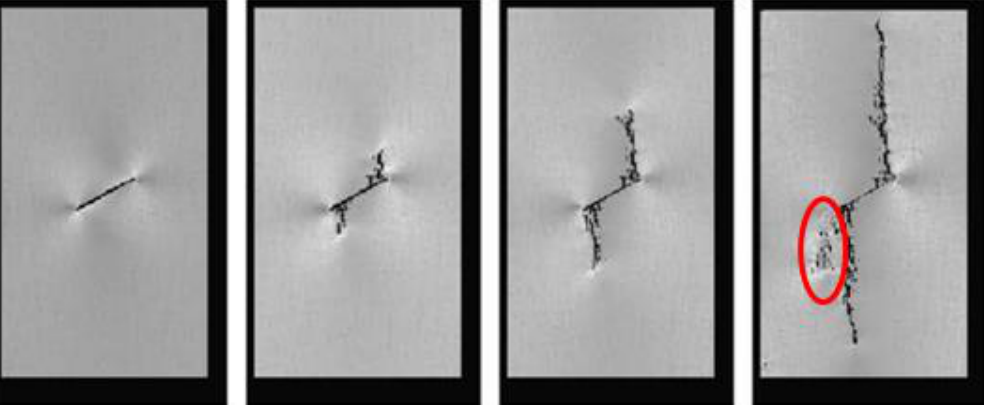
Figure 14. Stress-strain curves of the three case models in uniaxial compression simulation experi- ments. As can be seen from the curves in Figure 14, the three cases all experienced three stages in the experimental process of the model: 1. Compaction stage The preset joints in the models displayed closed compaction, and the whole models are axially compressed and laterally expanded, so the axial strain was positive strain (axial compression) and the lateral strain was negative strain (lateral expansion) on the stress – strain curve. 2. Elastic deformation stage